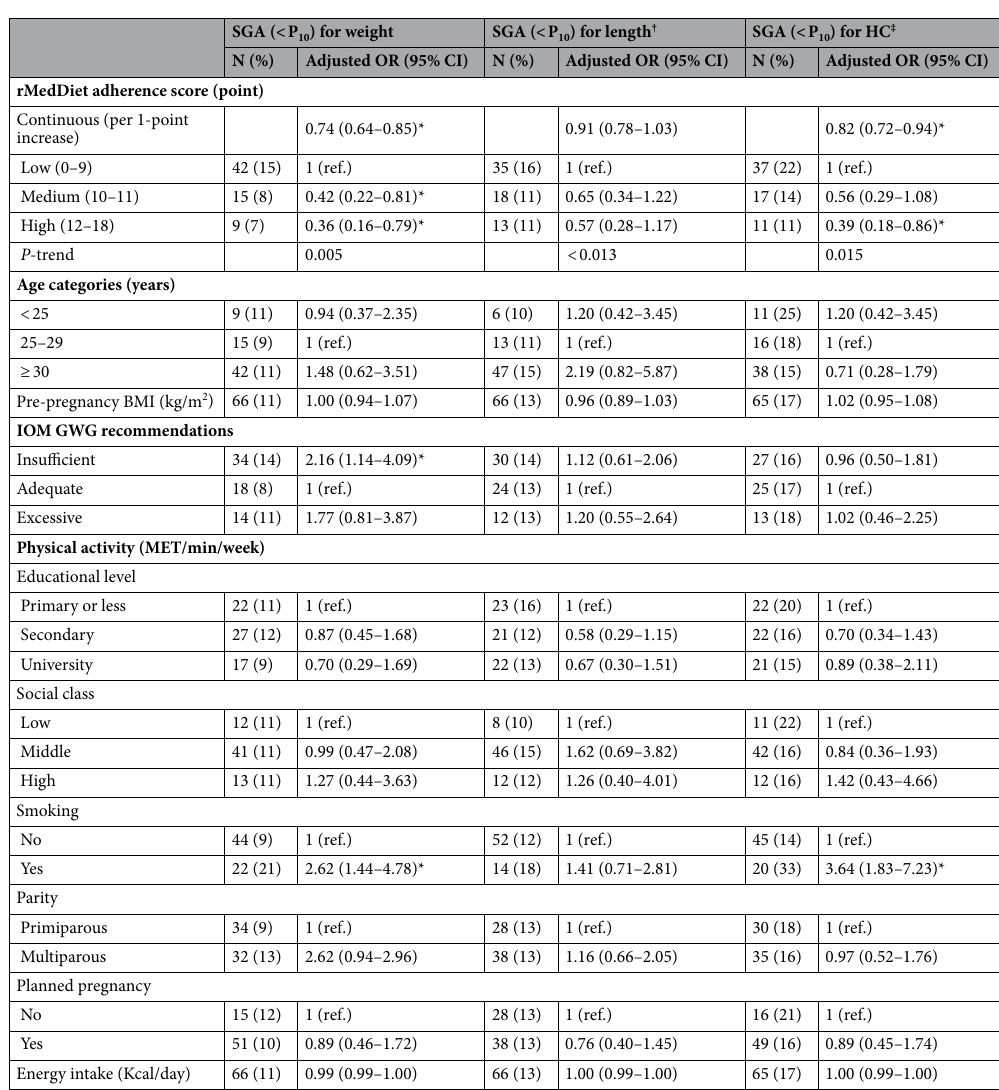
Table 3. Multivariable-adjusted Odds ratios (ORs) and 95% confidence intervals (95% CIs) for associations between Mediterranean diet categories during pregnancy and SAG (< P 10 ) in weight, length and head circumference (n = 614). Logistic regression models were used to calculate Odds ratios (OR) and 95% confidence intervals (IC al 95%). BMI, body mass index; SGA, small-for-gestational-age; rMedDiet, Mediterranean diet; P 10, percentile 10. Logistic regression models were mutually adjusted for all characteristics displayed in this table. *p value < 0.05. † n = 495. ‡ n =